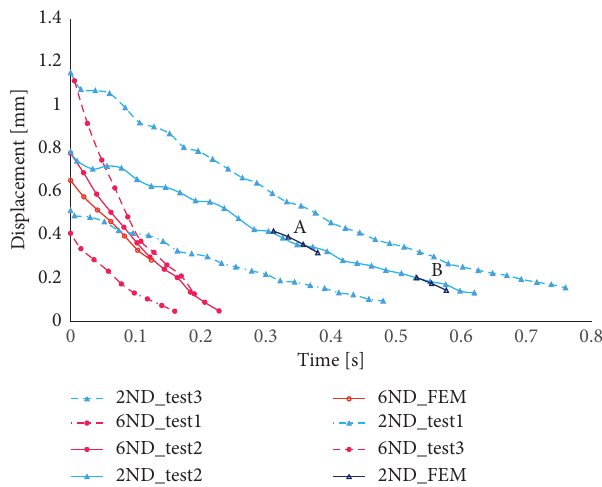
Figure 19: Envelopes of the vibration attenuation for 2ND an 6ND modes—experimental and FEM results.